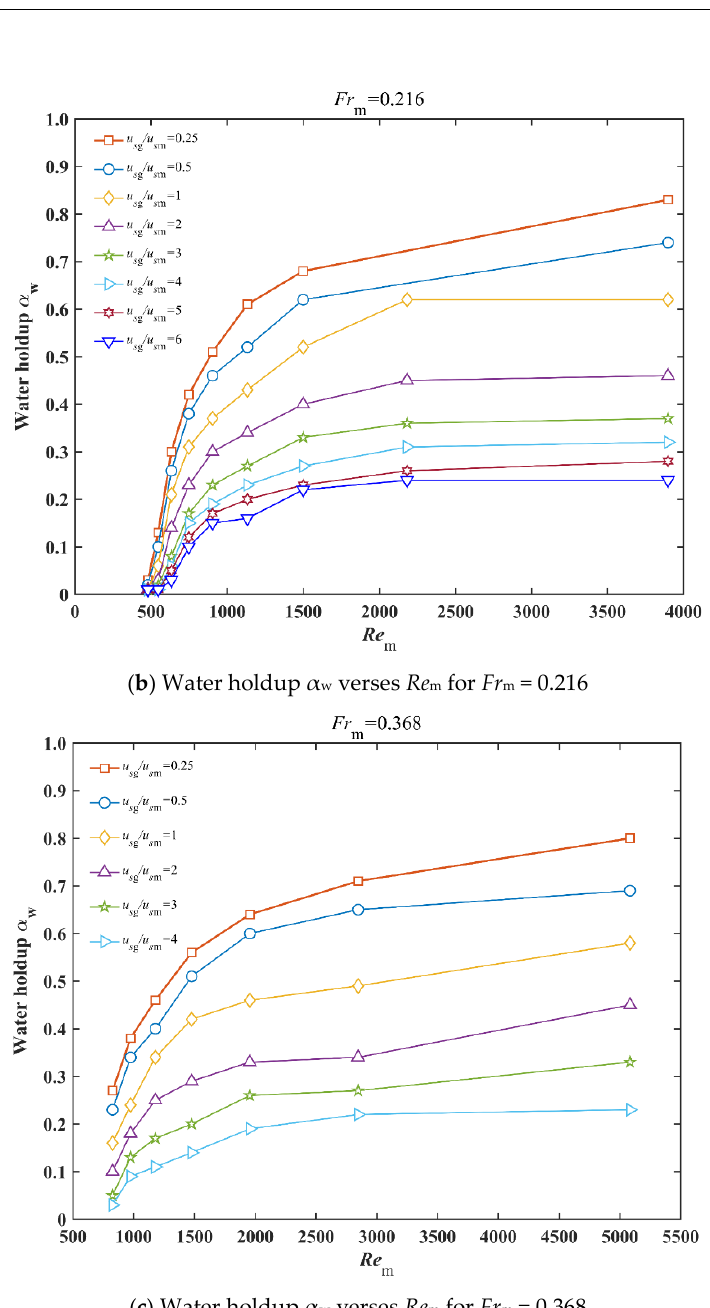
Figure 11. Effect of Re m on water holdup α w in the vertical section for different u sg /u sm values. The input water cut ε w ranged from 10% to 90%. Fr m was fixed at ( a ) 0.105, ( b ) 0.216, and ( c ) 0.368.